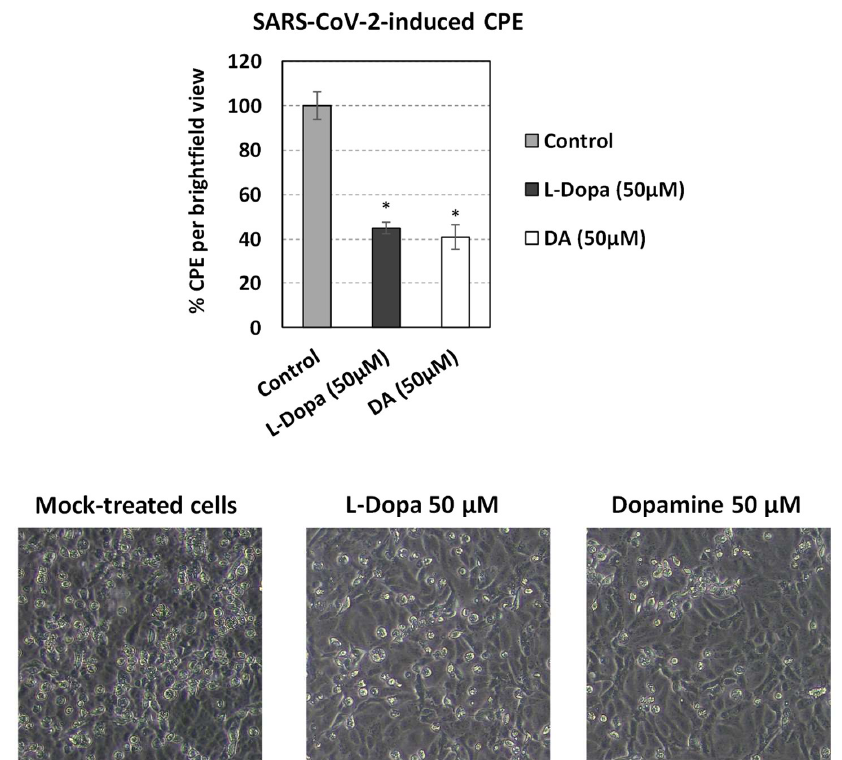
Figure 10. Effect of the DDC biosynthetic product (dopamine) and the DDC substrate (L-Dopa) on the SARS-CoV-2-induced cytopathic effect (CPE) in cell culture. Vero E6 cells were inoculated with SARS-CoV-2 (m.o.i. = 0.1) for 1 h and were subsequently treated, or not-treated (Control), with non- cytotoxic concentrations of L-Dopa or dopamine (DA). The virus-induced CPE was determined using an inverted microscope and representative images are shown in the lower panel. The observed CPE in the infected non-treated cells was set to 100%. Bars represent mean values from three independent experiments in triplicates. Error bars indicate standard deviations. p -values were determined by the Student’s t -test. * p < 0.0001 vs. Control.